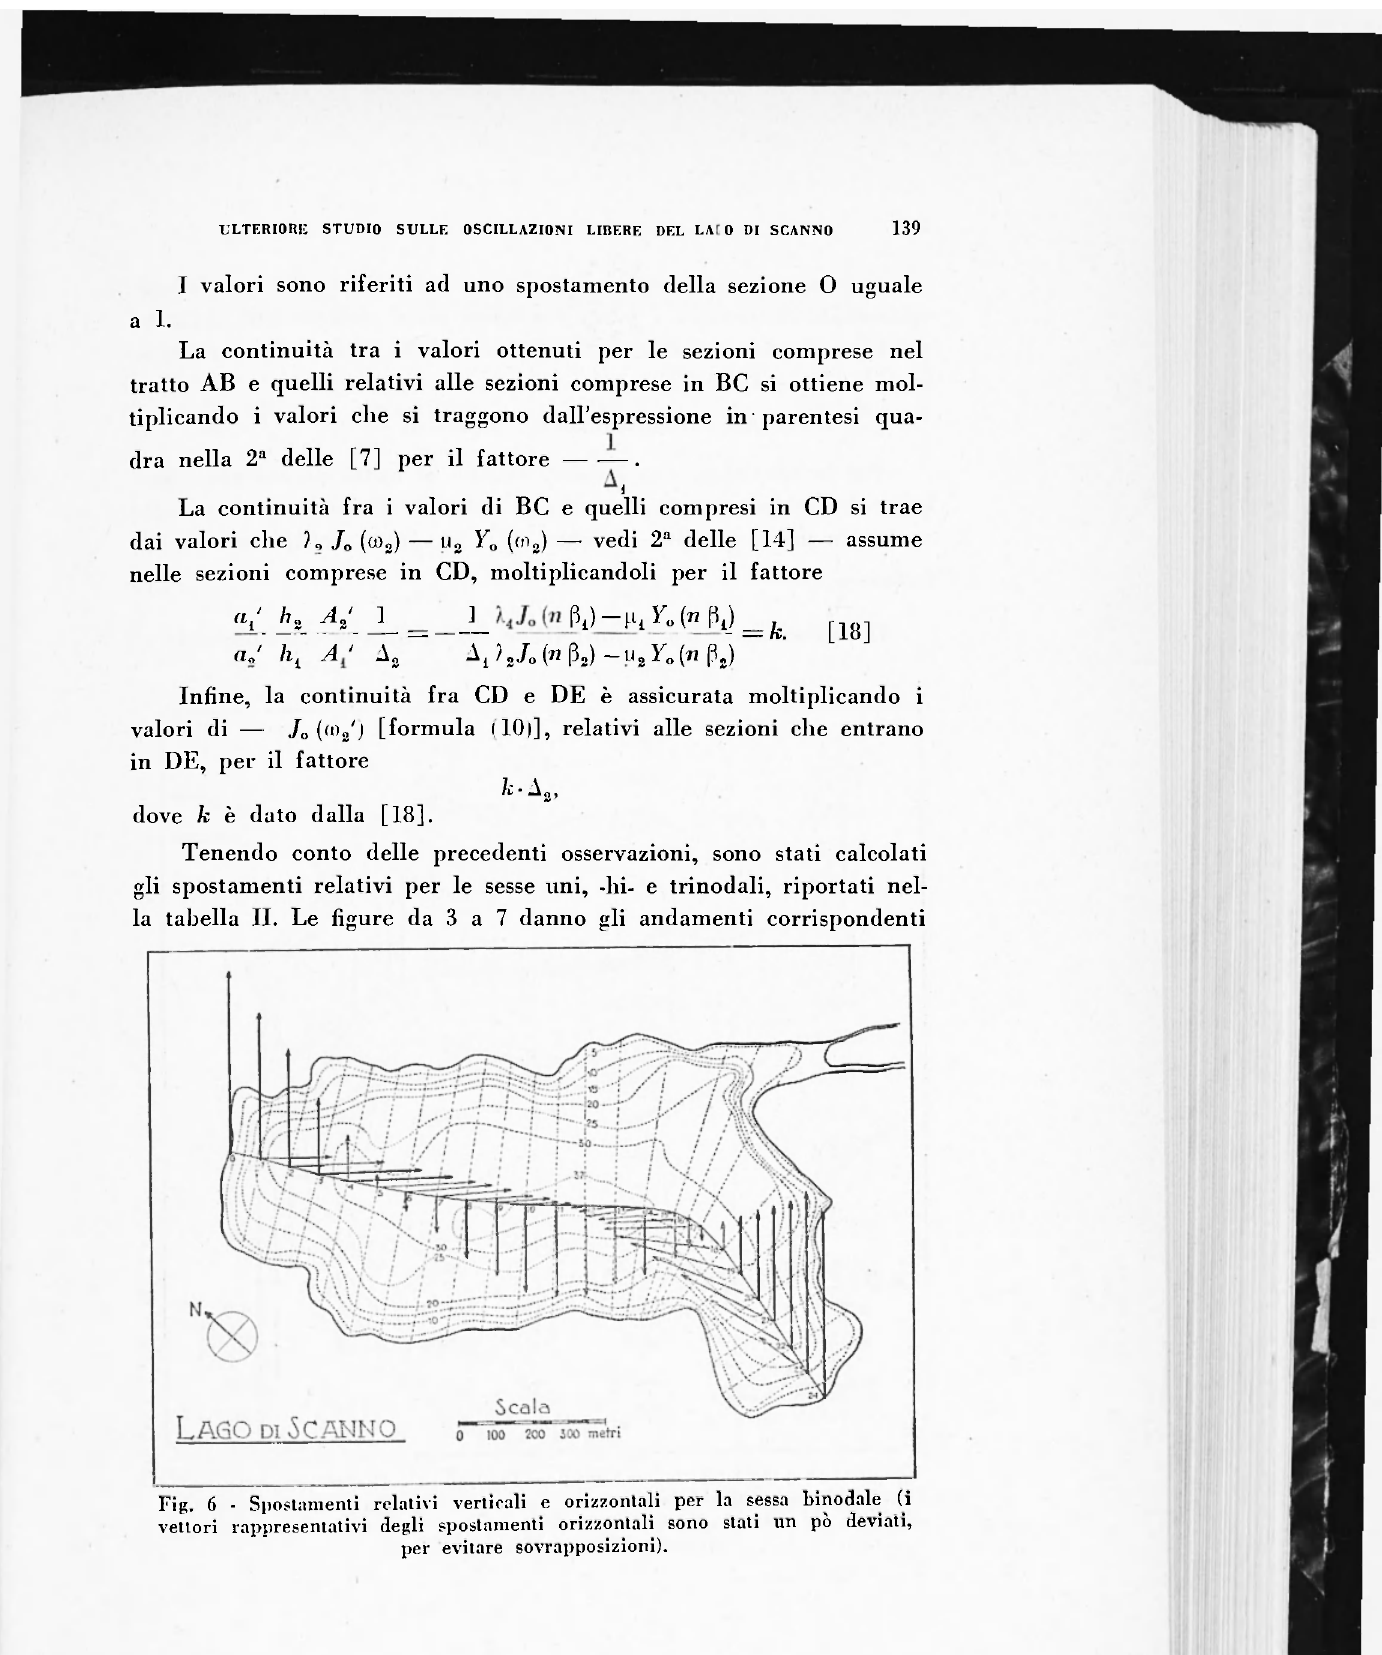
Fig. 6 - Spostamenti relativi verticali e orizzontali per la sessa binodale (i vettori rappresentativi degli spostamenti orizzontali sono stati un pò deviati, per evitare